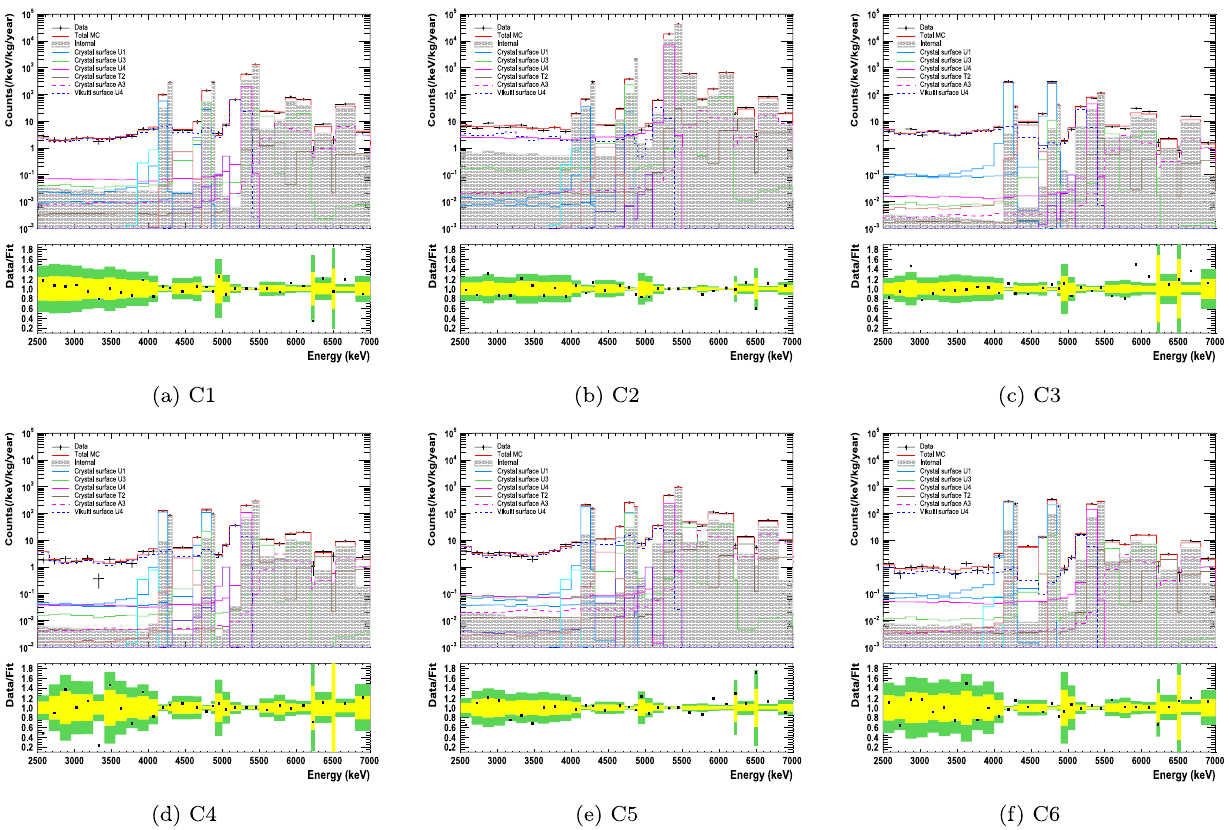
Fig. 12 Measured energy spectra are compared with the fitted results for six crystals. The lower panel shows the bin by bin ratios of data to fitted results. The colored bands centered at 1 in the lower panel represent 1 and 2 σ of statistical uncertainty